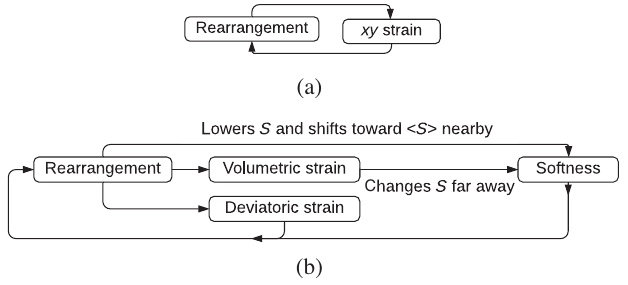
FIG. 1. (a) In a typical elastoplastic model under an xy -shear strain, rearrangements give rise to xy strain and that strain can trigger regions of low local yield strain to rearrange. This interplay gives rise to rearrangement avalanches. (b) Summary of the interplay between rearrangements, strain, and softness (local structure) in our augmented structuro-elastoplasticity (STEP) model. A rearrangement decreases the softness of nearby particles, alters the softness of far-away particles through volu- metric strain, and exerts a deviatoric shear strain on all particles. Softness determines the local yield strain, and the local deviatoric strain can trigger regions of high softness (low local yield strain) to rearrange, giving rise to rearrangement